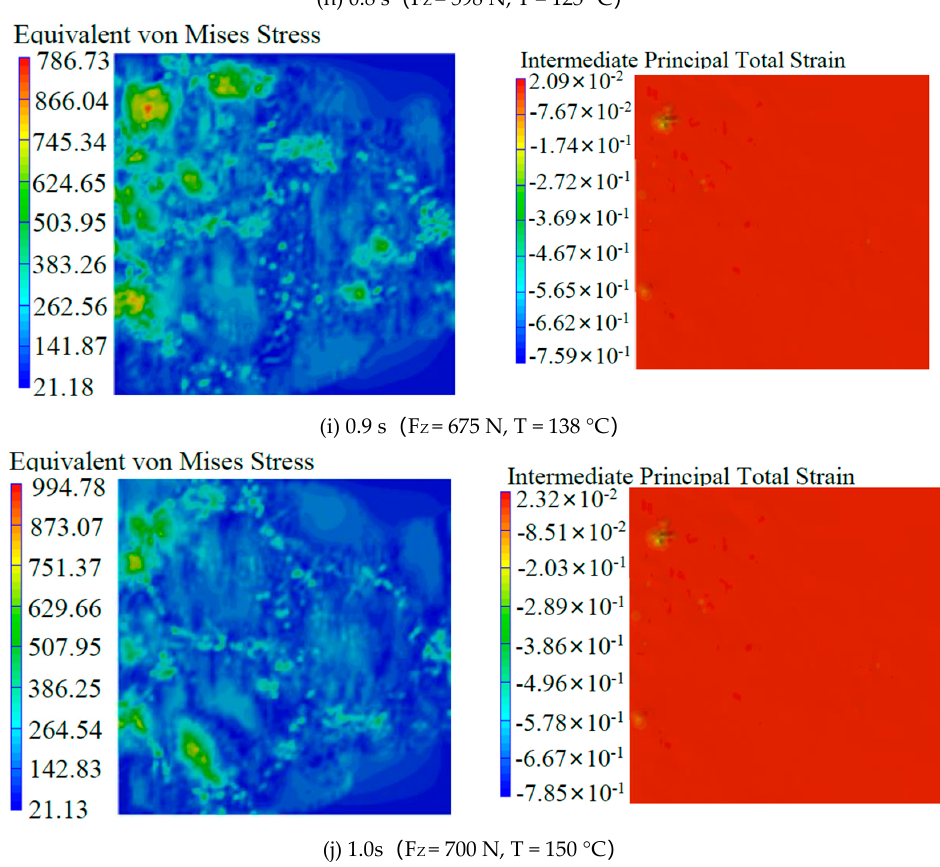
Figure 6. Stress and strain contour image for TiBw/TC4 composite.